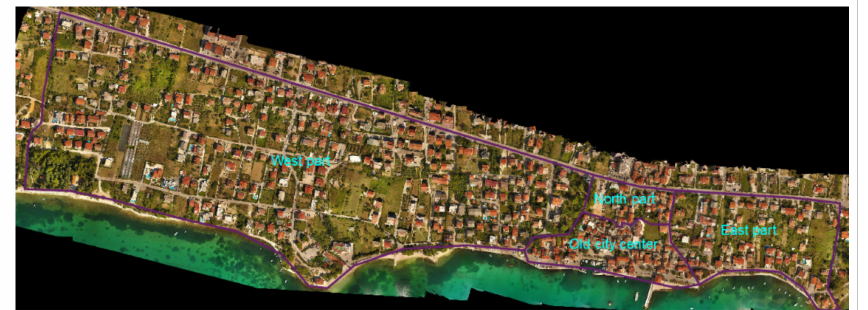
Figure 3. Kaštel Kambelovac test site with four characteristic